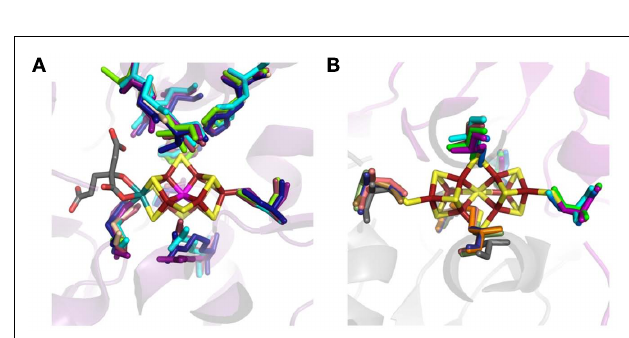
FIGUREA4 | Structural alignment of the inferred structures of DK homologs indicating conservation in the active site (A) and P-cluster binding cavity (B). Ribbon diagram of the superimposition of NifDK from Azotobacter vinelandii AvOP (D, violet and K, gray), NifDK from Methanococcus maripaludis strain S2 (D, wheat and NifK, blue), UncDK from Methanocaldococcus sp. FS406-22 (D, cyan and K, orange), UncDK from Roseiflexus sp. RS-1 (D, marine, and K, sand),VnfDK from Methanosarcina acetivorans str. C2A (D, raspberry, and K, pale green), and AnfDK from Azotobacter vinelandii AvOP (D, green, and K, salmon), with the FeMo-co (A) and P-cluster (B) depicted as stick representations. Dark red, Fe; yellow, S; gray, C; red, O; teal, Mo; unknown, magenta. Protein Data Bank ID for Azotobacter vinelandii AvOP 1MIN.